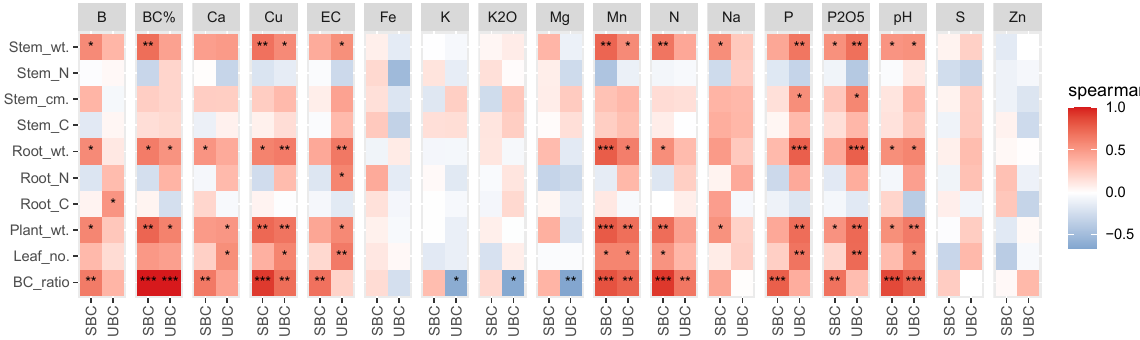
Figure 3. Spearman correlation of soil physicochemical variables and plant growth parameters among soil samples treated with saturated and unsaturated biochar ( p -value < 0.05 *, p -value < 0.01 **, p -value < 0.001 ***).